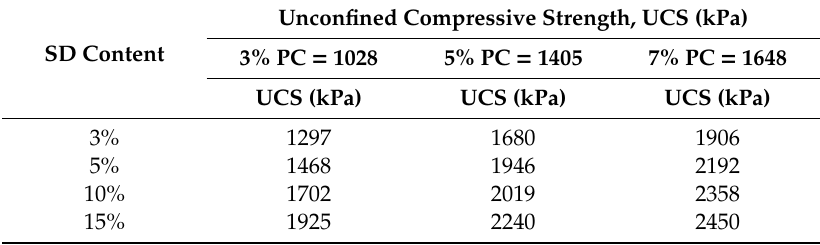
Table 10. UCS results before sulphate exposure in presence of SD (90 days curing).